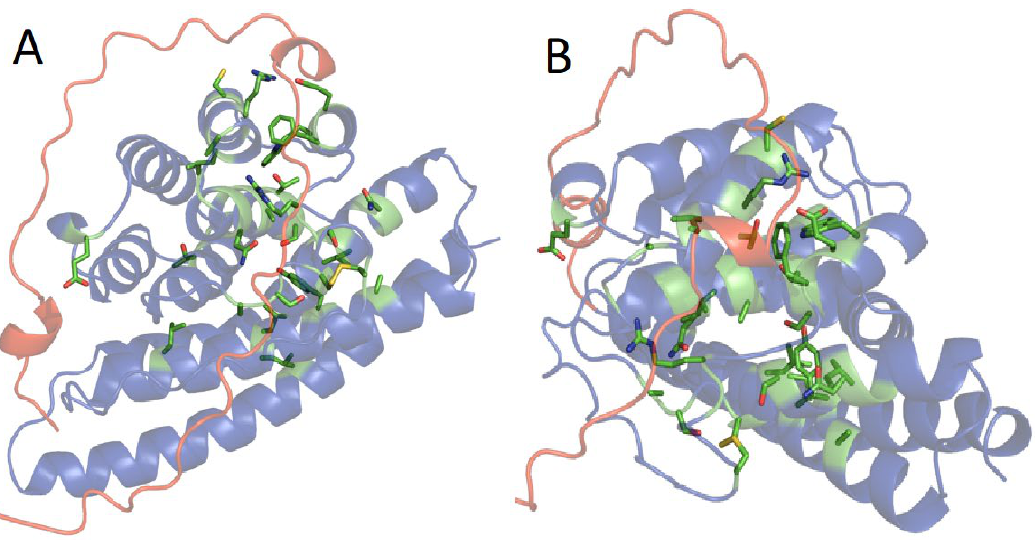
Figure 6. Heterocomplex of L-fib (blue) and H-fib C-terminus (red) of H . occidentallis . ( A ) Front, looking through H6 as before. ( B ) Topview. All conserved amino acids were colored green to highlight clustering.